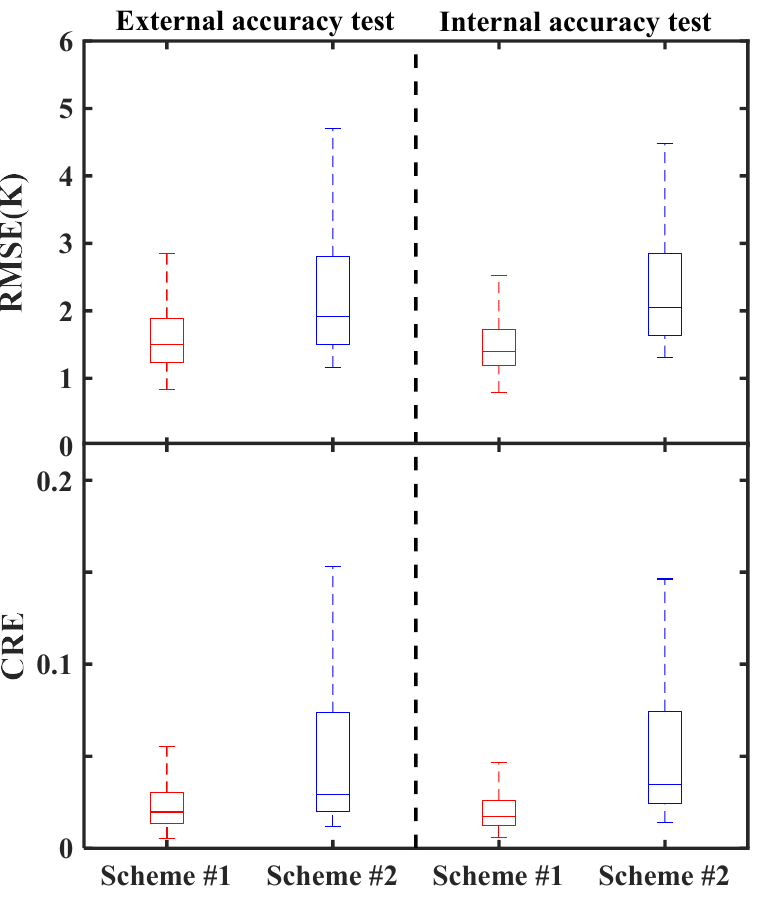
Figure 4. Boxplots of the RMSE and CRE for the two schemes in different tests. Table 1. Statistical values of the external accuracy test for these ten experiments in different schemes.